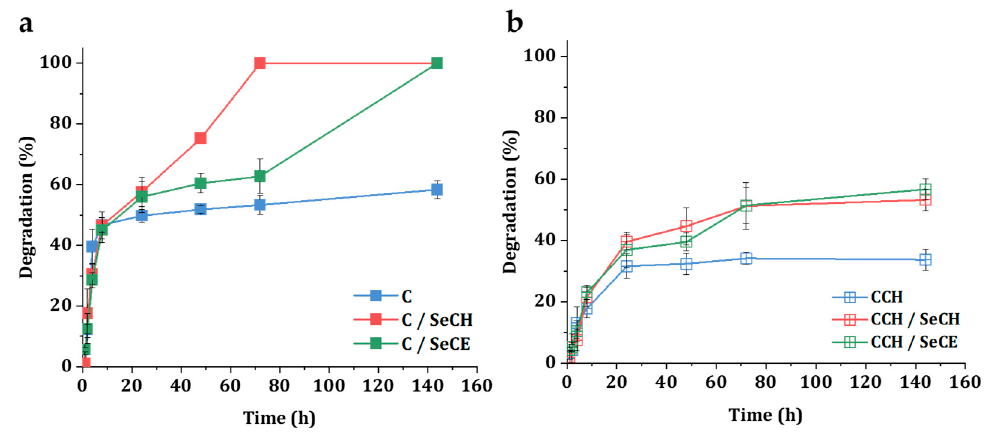
Figure 7. Degradation in the presence of collagenase (in a PBS environment with a pH 7.4 and at 37 °C) of C-based scaffolds ( a ) and CCH-based scaffolds ( b ) with and without SeNPs.